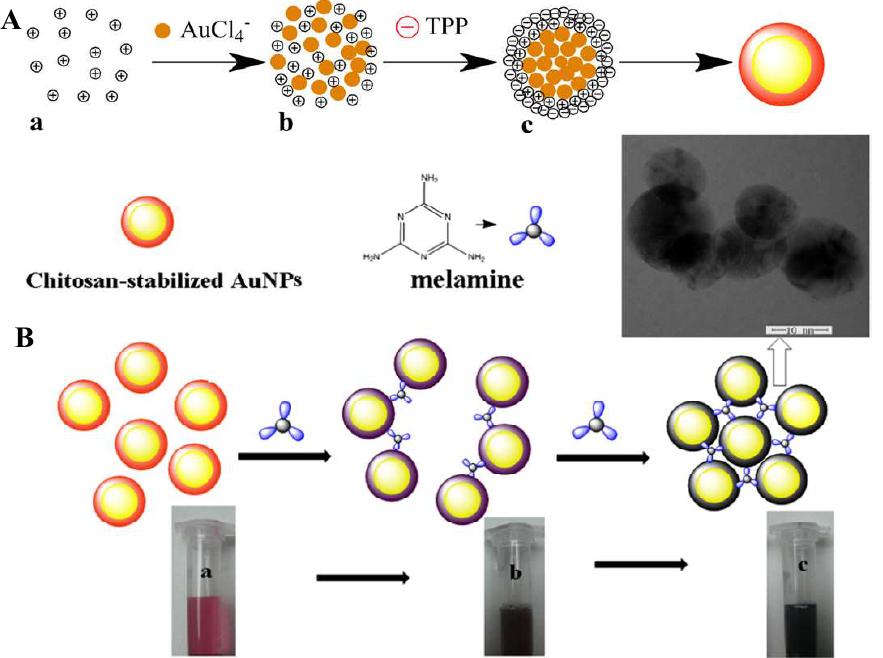
Figure 6. Demonstrates the sensing action of CS stabilized AuNPs. Schematics show the formation of CS stabilized AuNPs. ( A ) Schematic representation of the formation of chitosan-stabilized AuNPs where ( a ) represents the polycationic form of CS, ( b ) shows the formation of ion pairs with AuCl 4- and ( c ) shows the CS stabilized AuNPs. The red circle indicates the tripolyphosphate (TPP); ( B ) Schematic representation of colorimetric mechanism for melamine detection. The insert is photographs of solution of tubes ( a ) CS stabilized AuNPs, ( b ) CS stabilized AuNPs with melamine, ( c ) CS stabilized AuNPs with melamine and TEM image of chitosan-stabilized AuNPs with melamine. The melamine detection is indicated by the color change of AuNPs. Reprinted with permission from Food Control . 2012 , 32 , 35–41, Copyright 2012, Elsevier [137].